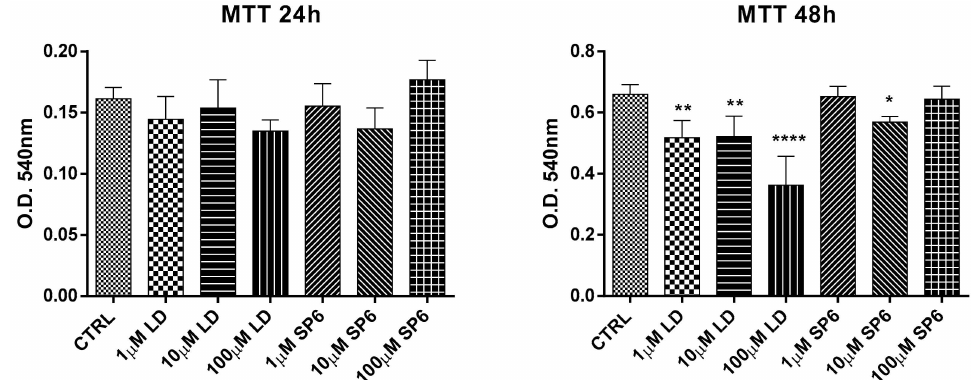
Figure 2. Dose-response e ff ects of LD and SP6 in undi ff erentiated SH-SY5Y human neuroblastoma cells. MTT reduction assay in undi ff erentiated SH-SY5Y human neuroblastoma cells in the presence of